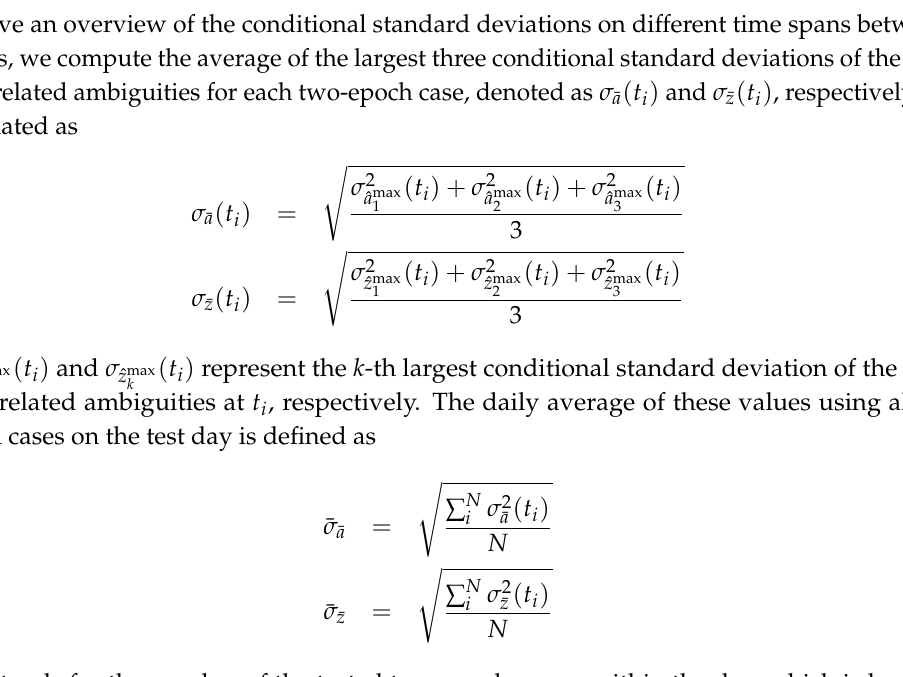
Figure 7. Conditional standard deviations of the ambiguities ( σ ˆ a σ ˆ z after the decorrelation with I = 1, · · · , i − 1) in single-, dual-, and triple-frequency cases for i | I phase-only two-epoch processing. The satellite orbit on DOY 240, 2018, and the ground truth of baseline CUAA-CUBB were used for the plot. The first epoch is the first second of the test day, and the time span between the two epochs are 1 ( top ) and 60 s ( bottom